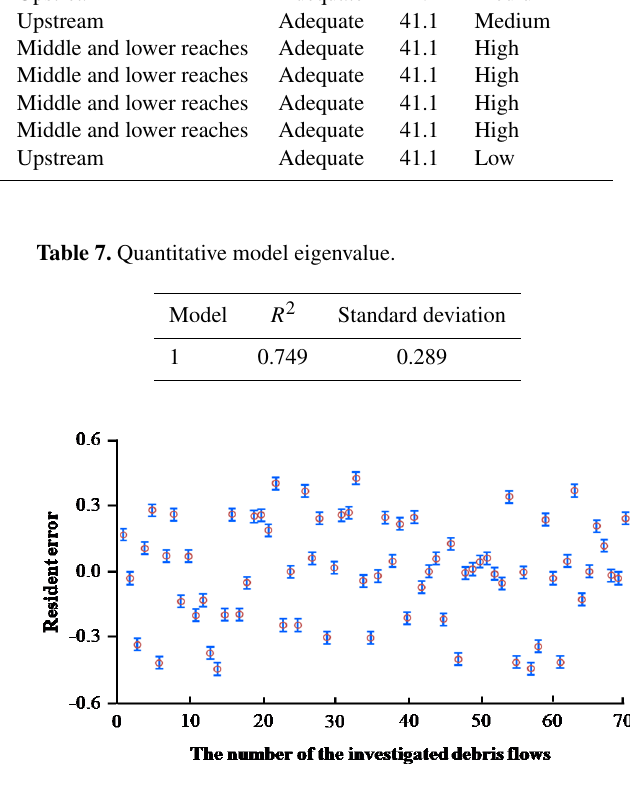
Figure 5. Comparison of actual susceptibility and predicted actual